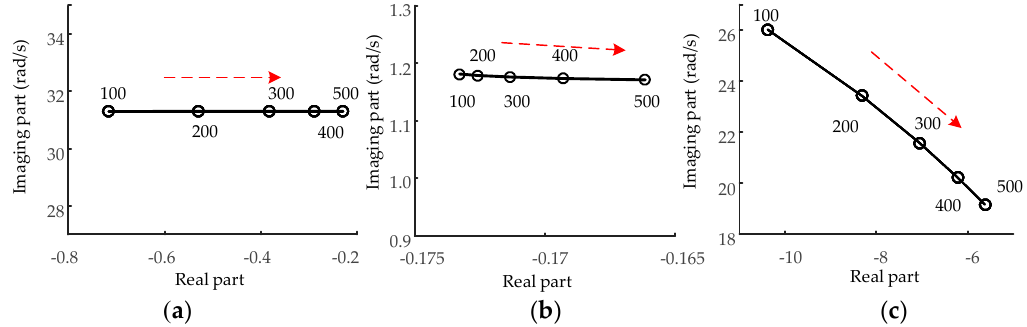
Figure 8. Impact of the wind farm capacity ( a ) Tor-1 mode ( b ) Tor-2 mode ( c ) Electro mode.